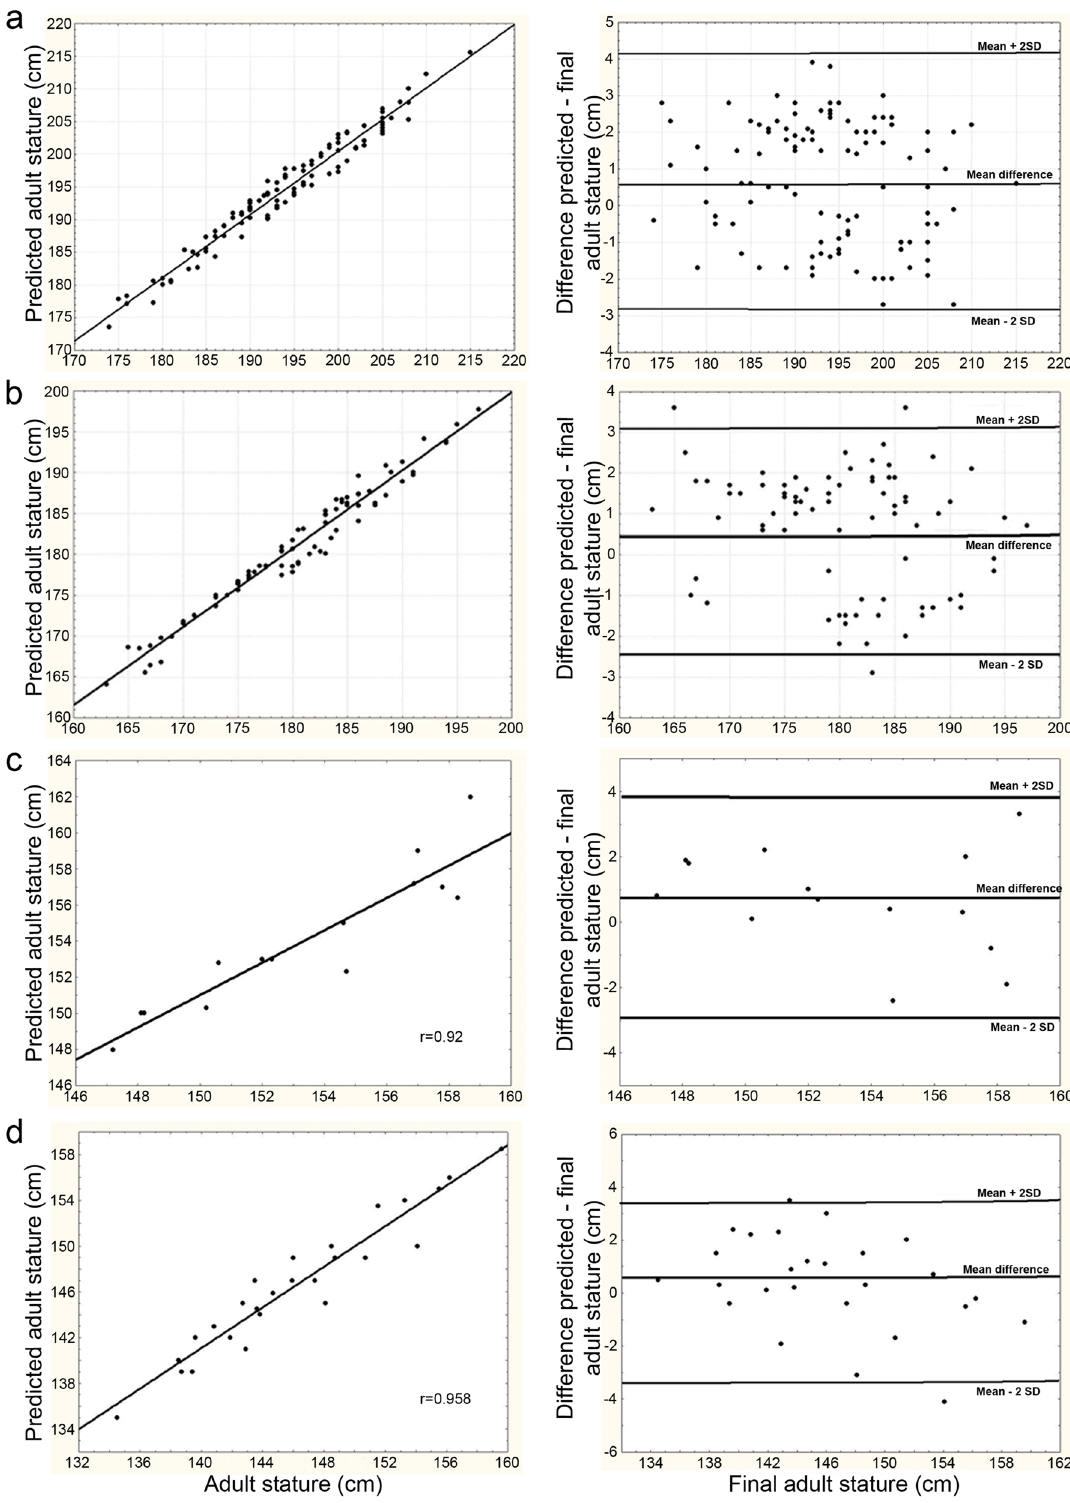
Figure 1. Regression curve and individual differences between estimated and actual adult stature in male ( a ) and female ( b ) basketball players and male ( c ) and female ( d )